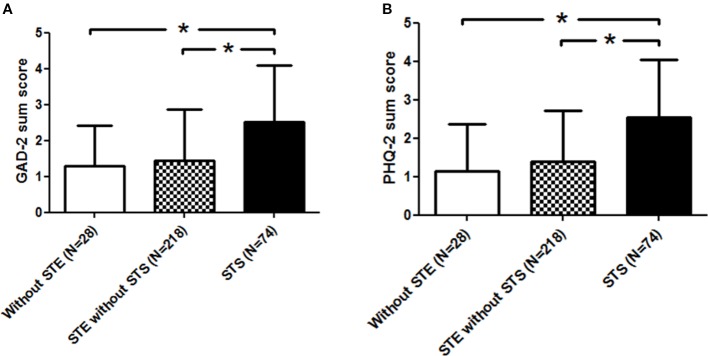

(A) Increased symptoms of anxiety symptoms in nurses who reported secondary traumatic stress (STS) compared to both other groups. *Indicates a significance level <0.001. (B) Increased symptoms of depression in nurses who reported secondary traumatic stress (STS) compared to both other groups. *Indicates a signifcance level <0.001.